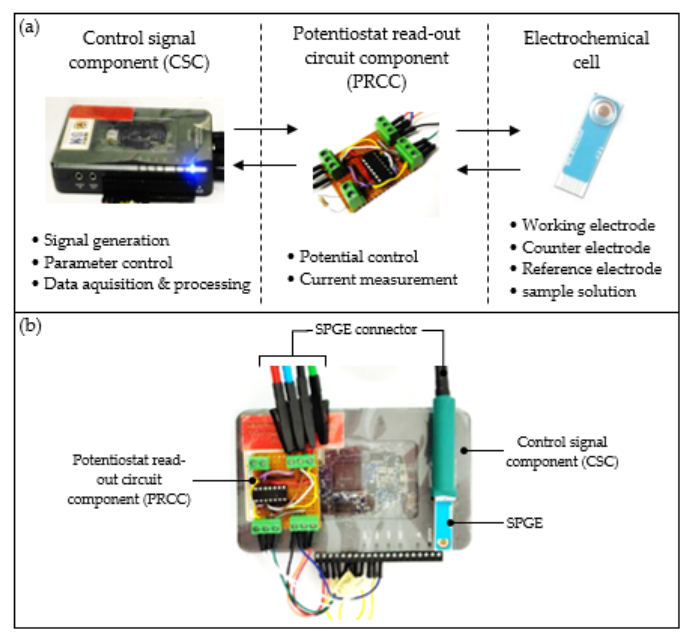
Figure 1. ( a ) The HMstat consists of a control signal component (CSC) and potentiostat read-out circuit component (PRCC) connected to the electrochemical cell (consisting of a screen-printed electrode gold (SPGE)) and ( b ) overall connection of HMstat. Appl. Sci. 2020 , 10 , x FOR PEER REVIEW